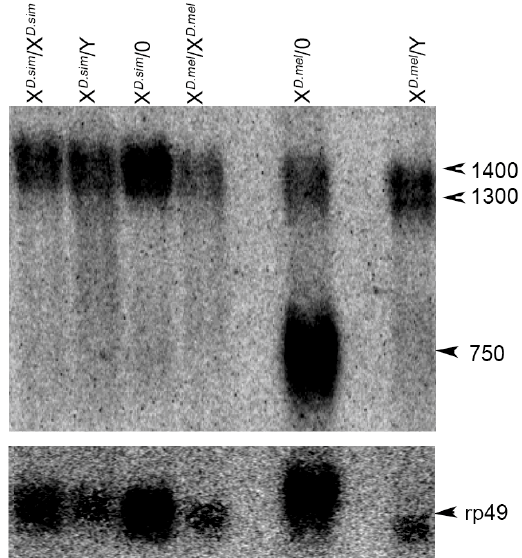
Figure 9. Northern blotting analysis of the Ste -like transcripts in D. simulans . Total mRNA extracted from adult ovaries and adult testes of the indicated genotypes probed with Ste cDNA antisense. No Ste transcript of 750 nt testes-specific is present in D. simulans ; it is present in D. melanogaster Y cry − males only. The larger ubiquitous transcripts are present in females and in X/Y and X/0 males in both species. Molecular weight of transcripts is indicated; the transcript of ribosomal protein rp49 was used as a loading control.